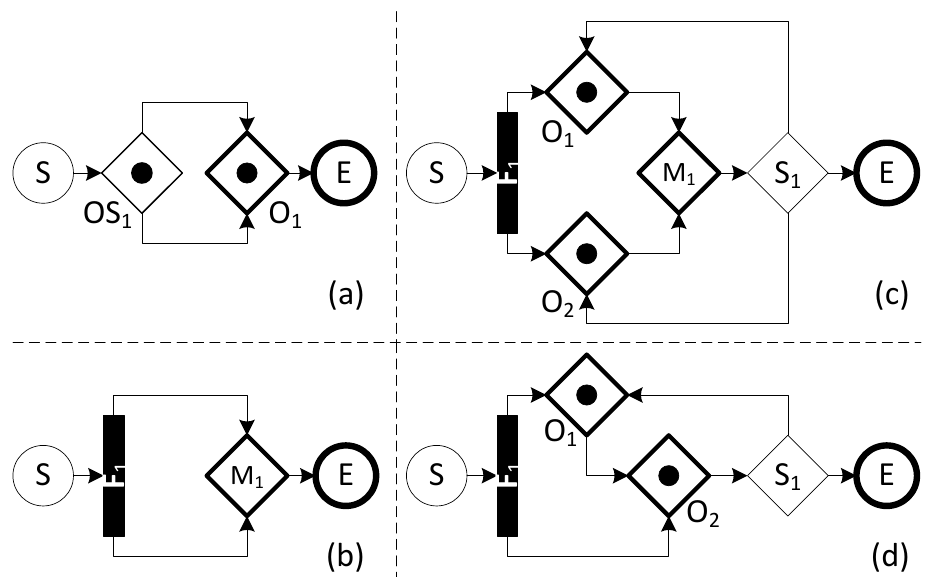
Figure 4. Sound and unsound workflow graphs